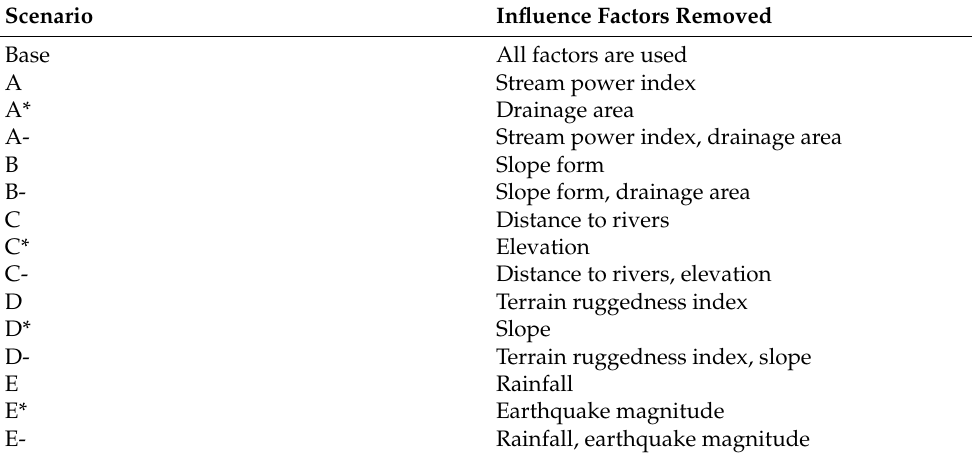
Table 2. Scenarios of removing highly correlated influence factors.